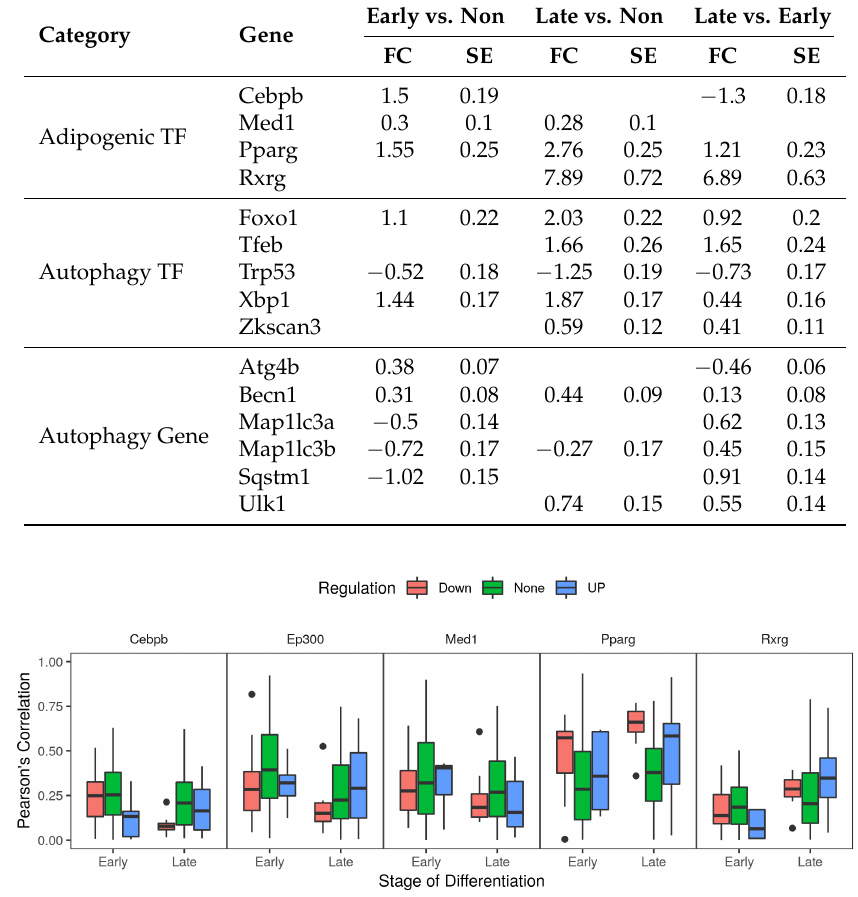
Table 1. Significant differentially expressed genes of adipogenic and autophagy transcription factors. FC, fold-change; SE, standard error.